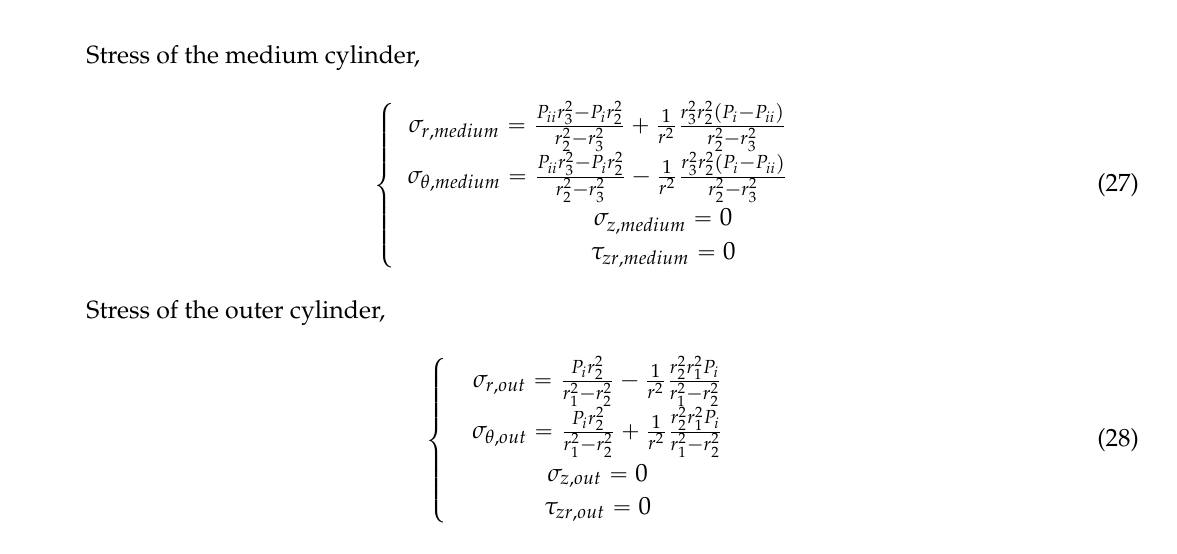
Figure 9. Calculation flow diagram for interference algorithm for multi ‐ layer thick ‐ walled cylinders (MTC) without consideration of assembly sequence. The interference fit between the i th layer and ( i + 1) th layer of the MLTWC is shown in Figure 8, which is composed of the outer surface of the i th thick ‐ wall cylinder and the inner surface of the ( i + 1) th cylinder. The radial displacement u of these two surface needs to satisfy the displacement coordination described in Equation (29), so that there is no gap or penetration between these two surfaces. (cid:1873) (cid:3036)(cid:2878)(cid:2869)(cid:3036)(cid:3041) (cid:3398) (cid:1873) (cid:3036)(cid:3042)(cid:3048)(cid:3047) (cid:3404) (cid:2012) (cid:3036),(cid:3036)(cid:2878)(cid:2869) (cid:4666)(cid:1861) (cid:3404) 1,2, … , (cid:1866) (cid:3398) 1(cid:4667) (29) where the superscript represents the inner and outer surface, respectively. Under the hypothesis of small elastic deformation, the interference fit of n MLTWC satisfies superposition principle, which can be equivalent to n axisymmetric thick ‐ wall cylinders with